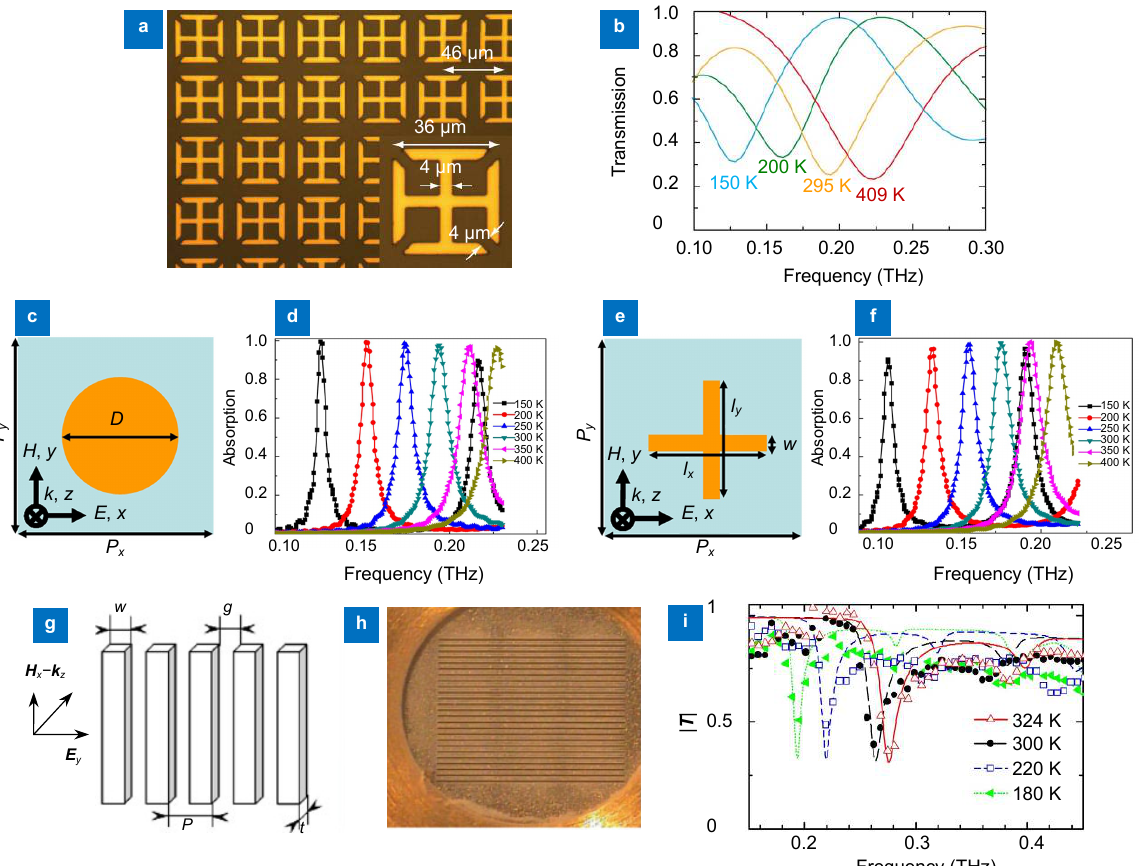
Fig. 7 | Thermal tuning of ferroelectric materials in active metamaterials. ( a ) Microscopic image of the metamaterial consisting of a gold electric split-ring resonator array fabricated on an STO substrate and ( b ) measured normalized THz transmission amplitude spectra through the metamaterial. ( c ) and ( e ) show the unit cell of the proposed frequency tunable metallic ring and cross absorbers, respectively and ( d ) and ( f ) show the calculated absorption spectra of the proposed frequency tunable metallic ring and cross absorbers at different temperatures, respectively. ( g ) Schematic view of the structure. ( h ) Scanning electron microscopy image of the metamaterial. ( i ) Theoretical and experimental transmission spectra. Figure reproduced from: ( a , b ) ref. 52 , Optical Society of America; ( c – f ) ref. 53 , Optical Society of America; ( g – i ) ref. 130 , Springer